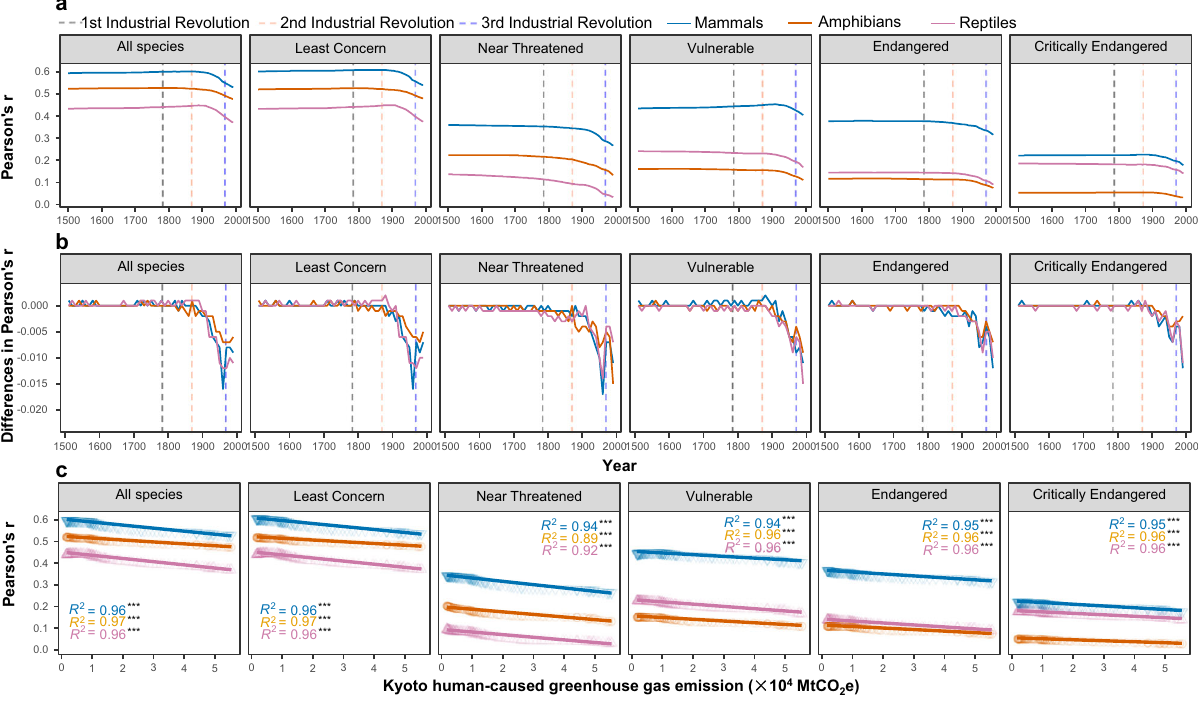
Fig. 2 Evidence of vertebrate extinction debts at the global scale. Correlation coef fi cients (Pearson ’ s r) per year between the richness of contemporary forest-dwelling vertebrate taxa and the area size of historical forested habitat at the global scale from 1500 to 1992 ( n = 493) a . Difference in correlation coef fi cients per decade from 1500 to 1992 ( n = 49) b . Linear relationship between yearly correlation coef fi cients and Kyoto human-caused greenhouse gas emissions ( n = 143) c